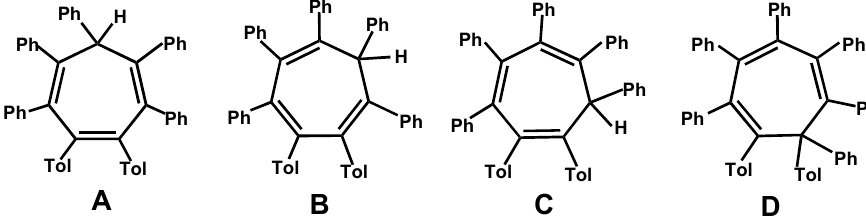
Figure 8. The four isomers ( A – D ) arising from [1,5]-hydrogen shifts upon ring-opening of the Diels-Alder adduct of triphenylcyclopropene and 2,5-diphenyl-3,4-di-( p -tolyl)cyclopentadienone.